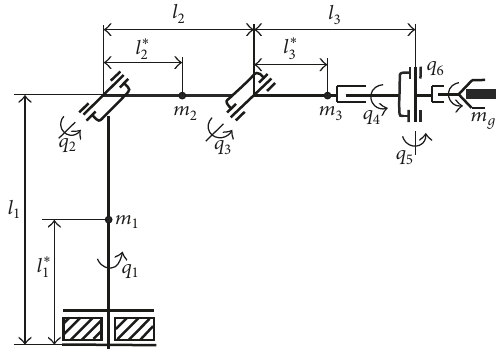
Figure 1: MM with PUMA type kinematic